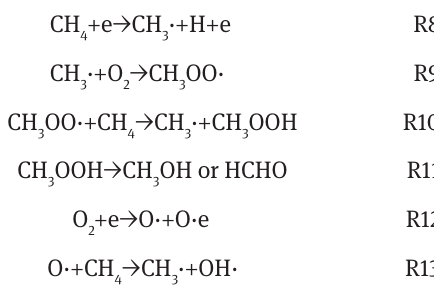
Figure 4 Image of dielectric barrier discharge (DBD) produced in a thin glass tube. Discharge power = 30 W; CH (A) without water injection; (B) and (C) with water